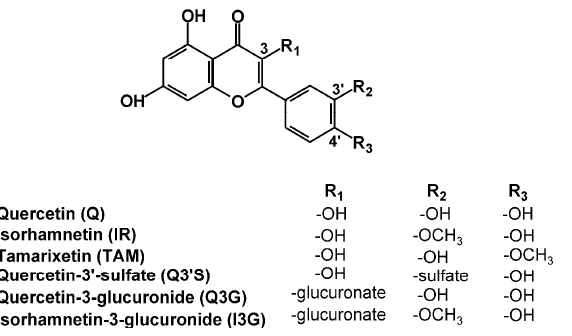
Figure 1. Chemical structures of quercetin and its conjugated metabolites with preserved flavonoid